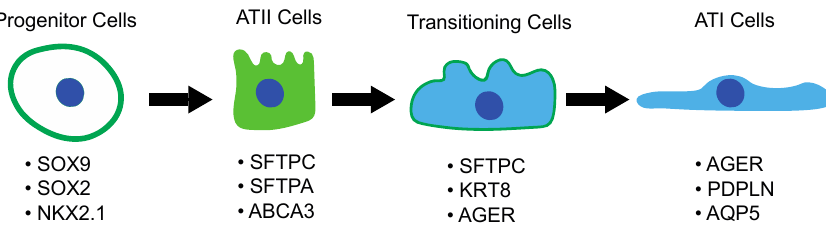
Figure 3. Transdifferentiation process from progenitor cells to ATI cells. Schematic depiction of the sequential differentiation process that occurs during cell differentiation into ATI cells as a response to injury, starting from a niche of SOX9/SOX2/NKX2.1-positive progenitor cells, which differentiate into ATII cells expressing SPC, SPA, and ABCA3. ATII cells then undergo a transition phase, where they begin to express KRT8 and markers of both ATII (SPC) and ATI cells (RAGE). Finally, from this intermediate state, cells transdifferentiate into terminally differentiated ATI cells positive for RAGE, podoplanin (PDPLN), and aquaporin 5 (AQP5).